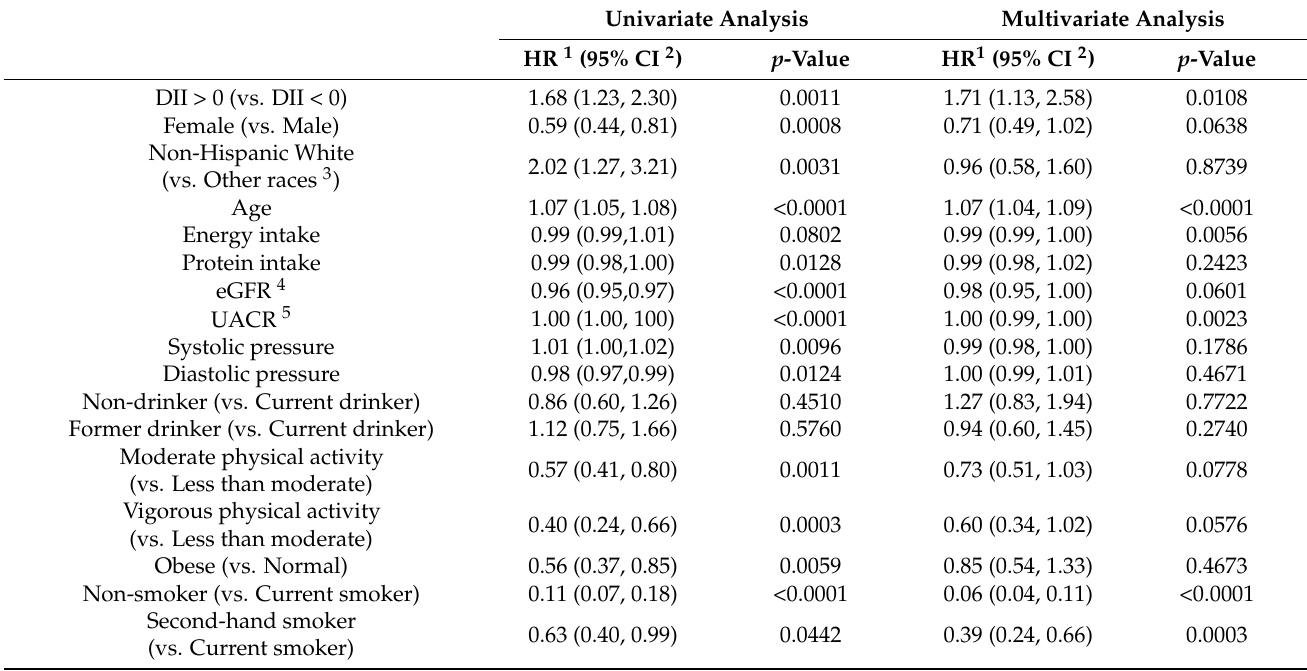
Table 4. Relationship of dietary inflammatory index to all-cause mortality among diabetes patients ( n = 178) carried out by Cox-regression